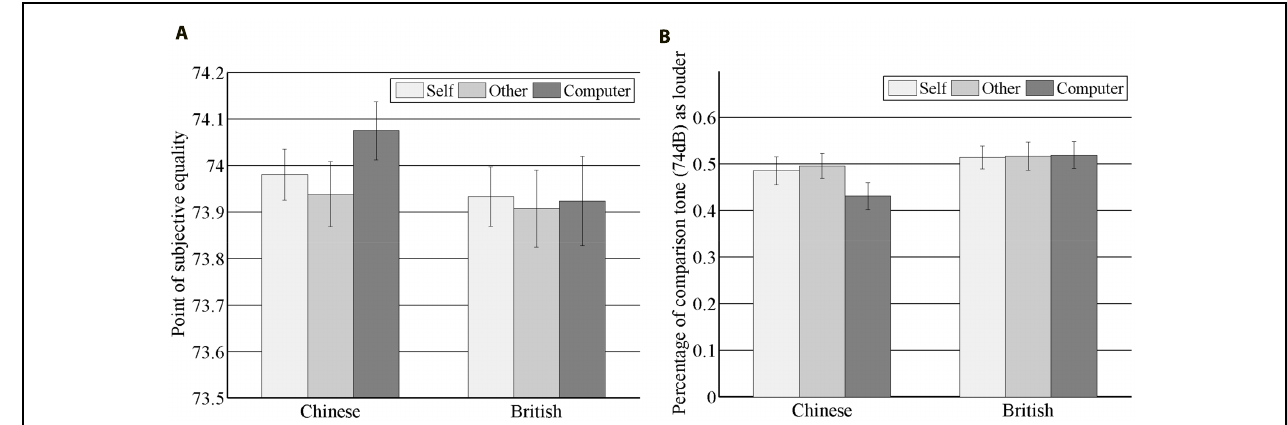
FIGURE 2 | Main results. Point of subjective equality (A) and Percentage of comparison tone (74 dB) as louder (B) in three conditions for Chinese and British. Vertical bars represent standard error. TABLE 1 | Summary of correlation analysis between SA self /SA other and four questionnaires scores using Pearson’scorrelation and Pearson bend correlation. Measure EQ SQ Independent SC Dependent SC PDI (overall)